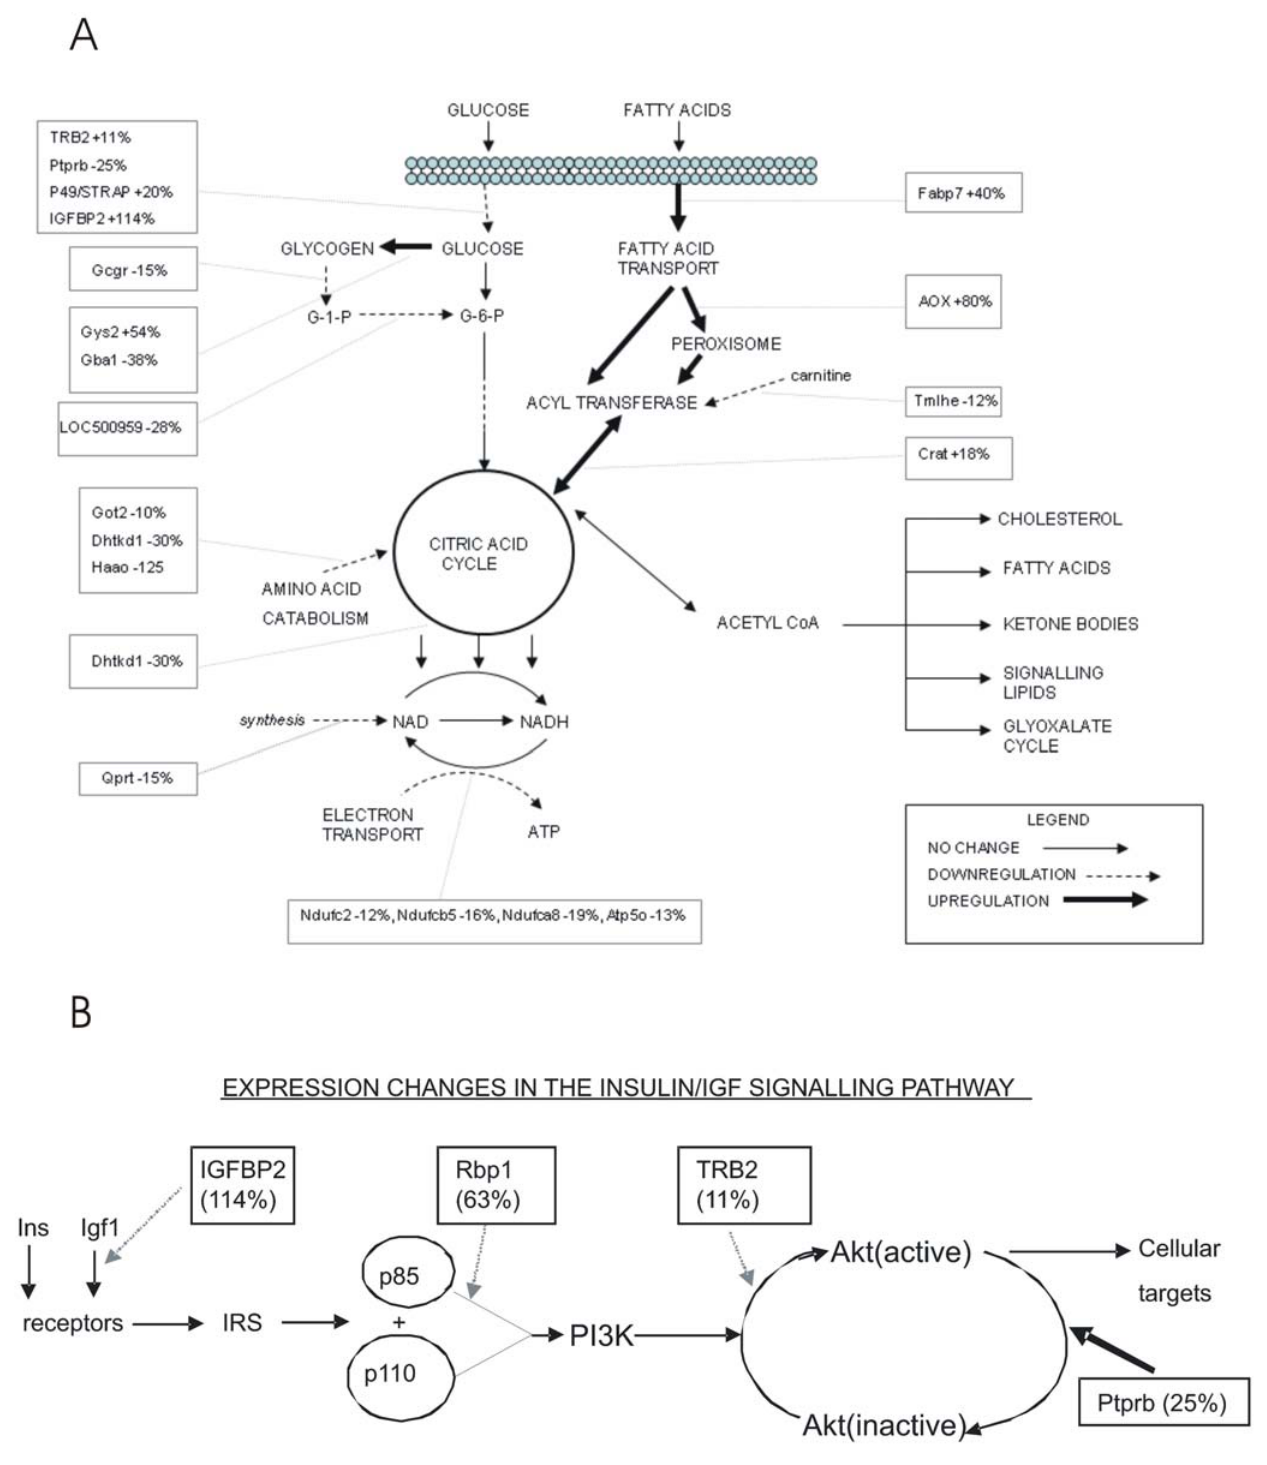
Figure 2. Genes that Influence Glucose, Fat, and Energy Metabolism Pathways and IGF-1 and PI3K Signaling Pathways. (A) Summarizes the interrelationships between pathways involved in glucose, fat, and energy metabolism and highlights differentially regulated genes that influence these pathways. (B) A summary of the genes that are altered in signaling through the IGF-1 and PI3K signaling pathways and their relevance to glucose and fat metabolism. Normal arrows indicate no change in gene expression; dashed arrows indicate down regulation; bold arrows indicate